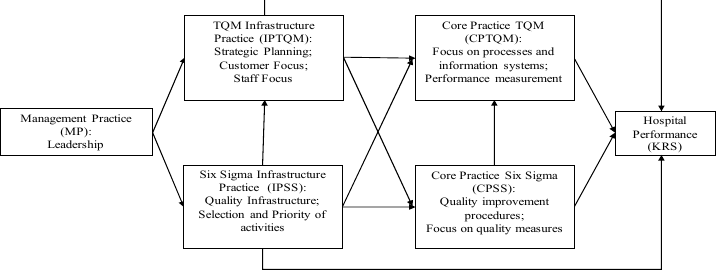
Fig. 1. Quality Management Alliance